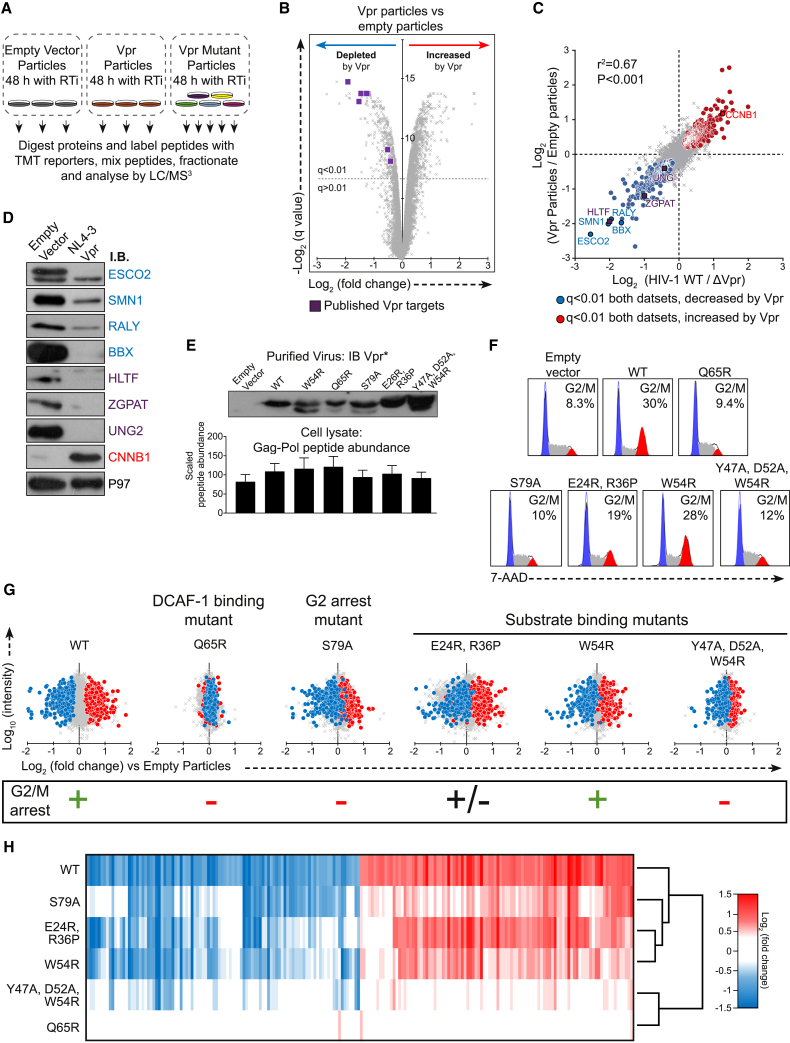
Analysis of the Nature of Vpr-Mediated Proteome Remodeling(A) Graphical summary of the Vpr viral particle TMT experiment. Three replicates of cells exposed to empty viral particles or Vpr-bearing viral particles along with single replicates of cells exposed to viral particles bearing five different Vpr mutants were analyzed.(B) Scatterplot displaying pairwise comparison between cells exposed to empty or Vpr-bearing viral particles.(C). Scatterplot comparing pairwise comparisons from two proteomics experiments, demonstrating the effect of Vpr in the context of HIV-1 infection (x axis, as shown in Figure 1A) or through cellular exposure to Vpr protein alone (y axis, as shown in Figure 2A). Labeled proteins were selected for confirmation by immunoblot in (D).(D) Immunoblot of selected proteins in CEM-T4 T cells transduced with an empty vector lentivirus or Vpr-encoding lentivirus 48 h after transduction.(E) Top: immunoblot of purified virus preparations used to infect cells for the proteomics experiment displayed in (A). Changes to amino acid sequence may reduce the affinity of antibody binding. Bottom: bar chart showing the average scaled abundance of matrix, capsid, and integrase peptides detected in the cell lysate by MS. Bars show mean and SD.(F) 7-AAD stain of cells exposed to empty vector, Vpr wild-type, or Vpr mutants. Watson pragmatic modeling was used to identify cells in G1 (blue), S (gray), or G2/M (red) phase.(G) Scatterplots showing pairwise comparison of each Vpr mutant tested and empty vector control, with defined groups of 302 Vpr-depleted and 413 increased proteins highlighted in blue and red, respectively.(H) Heatmap showing the behavior of the 100 proteins most depleted by Vpr particles (blue) and increased (red) within the defined significantly modulated subsets. Color indicates the log2 fold change of each protein in each condition compared with empty-particle treatment. Genes were clustered using uncentered Pearson correlation and centroid linkage, and conditions were clustered by column means.See also Figures S1 and S2.